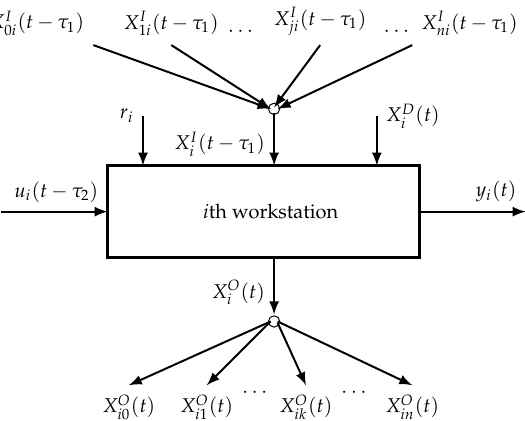
Figure 1. The general model structure of the n -workstation job shop system